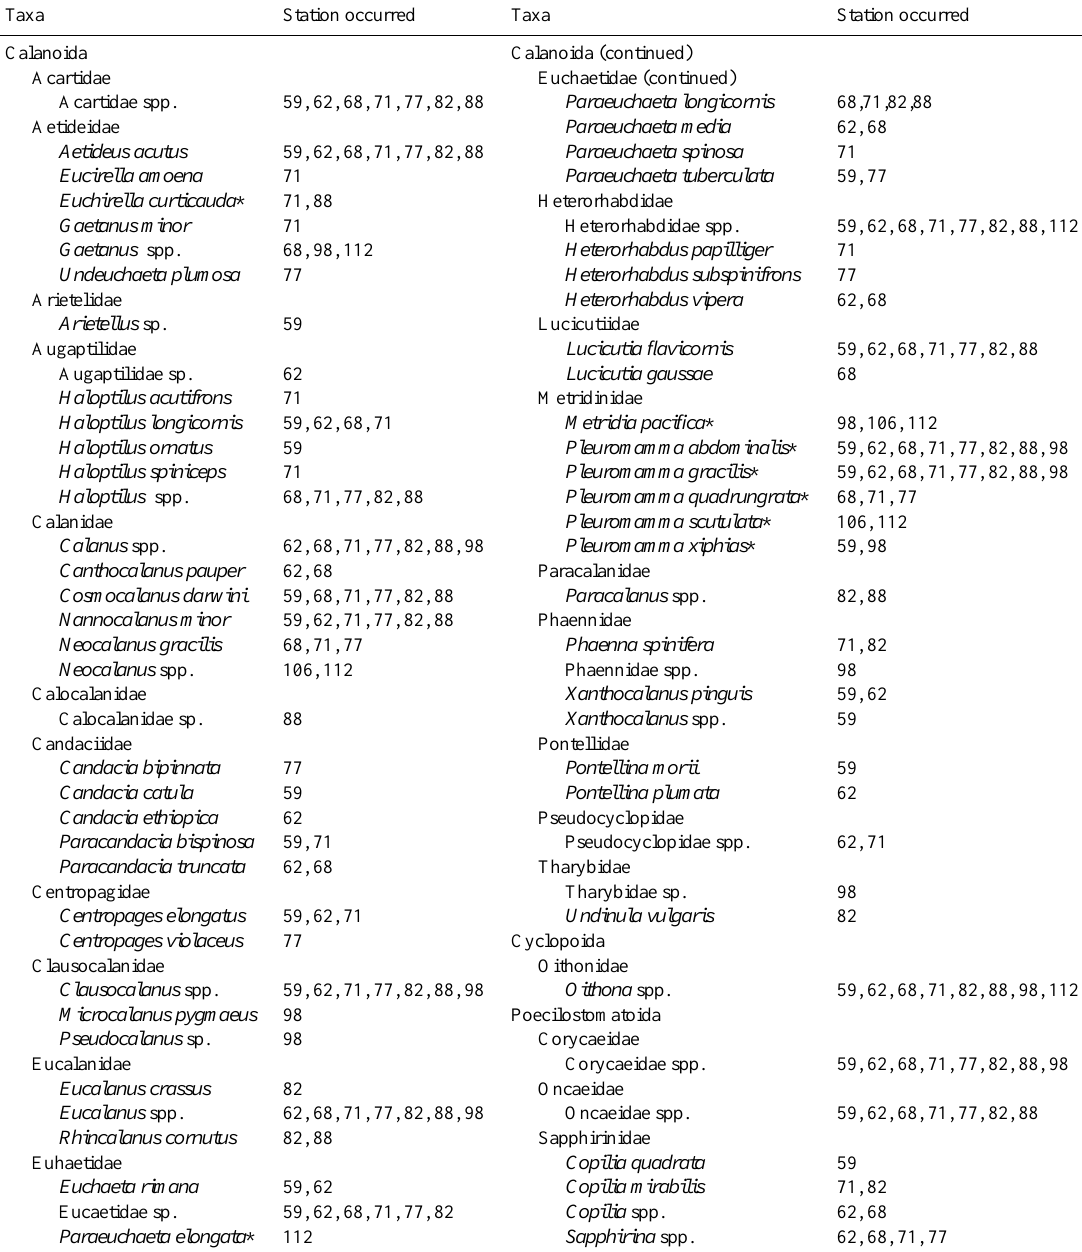
Table 3. Copepods collected from western North Pacific Ocean 10 months after the FNPP1 accident. Asterisks show diel vertical migratory